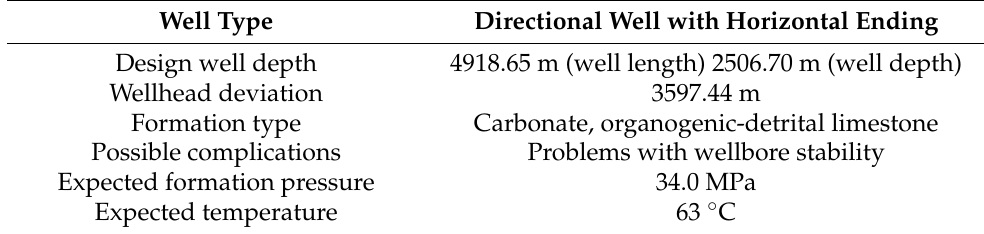
Table 3. Characteristics of the selected